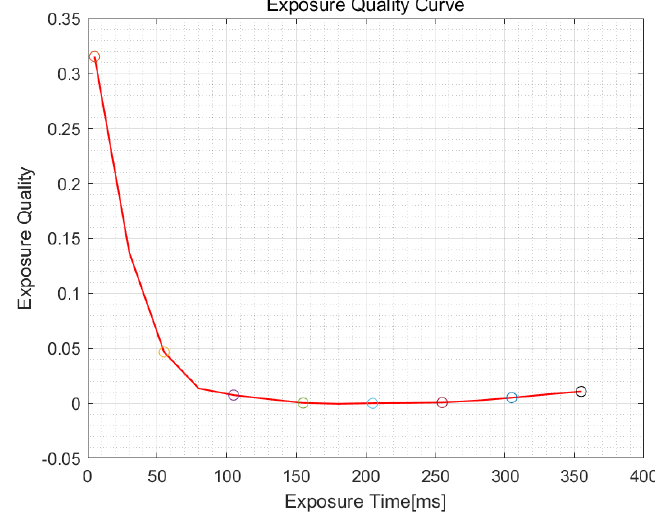
Figure 6. Curve of exposure quality under dark conditions.